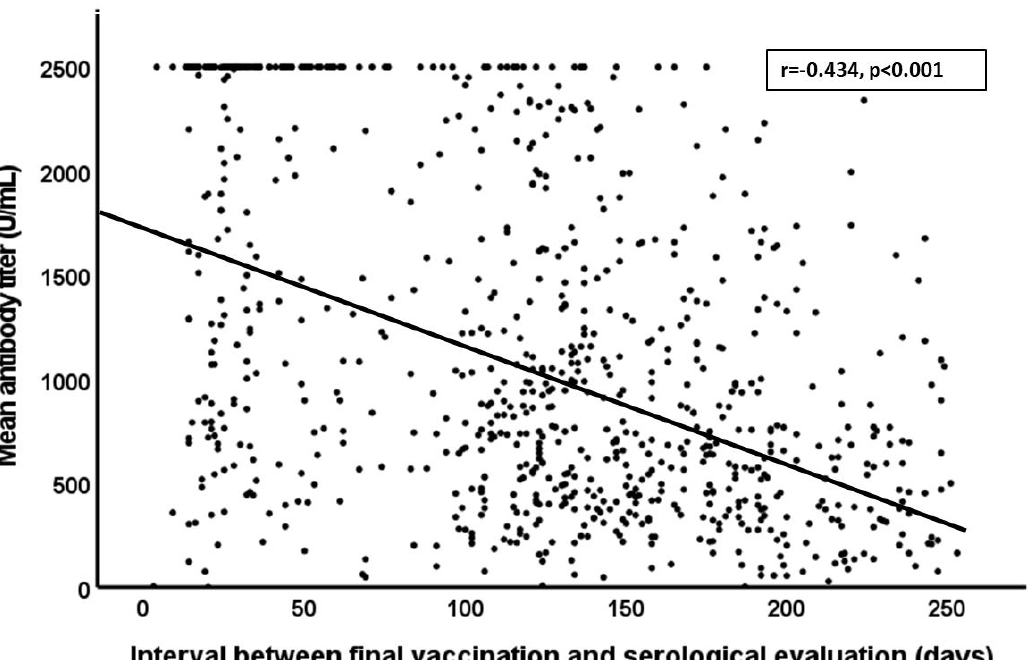
Figure 2. Correlation between mean antibody titer over time and days between final vaccination and serological evaluation.